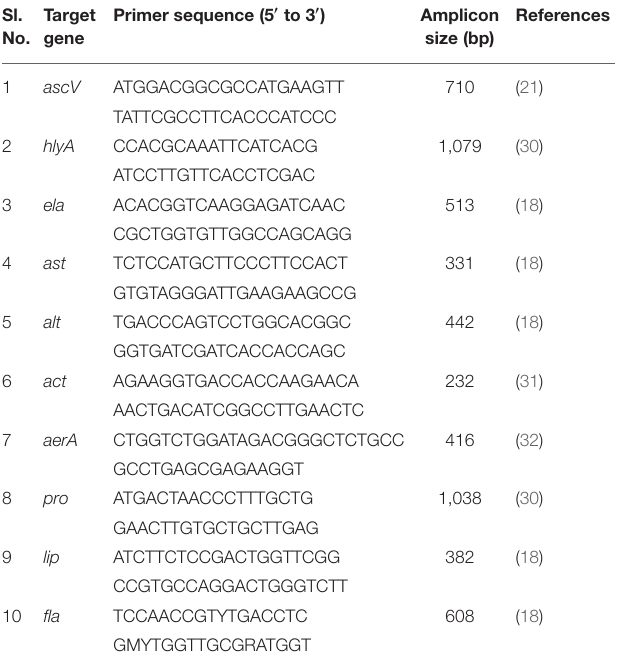
TABLE 1 | Details of PCR assays targeting virulence genes of Aeromonas spp. Sl. Target No.